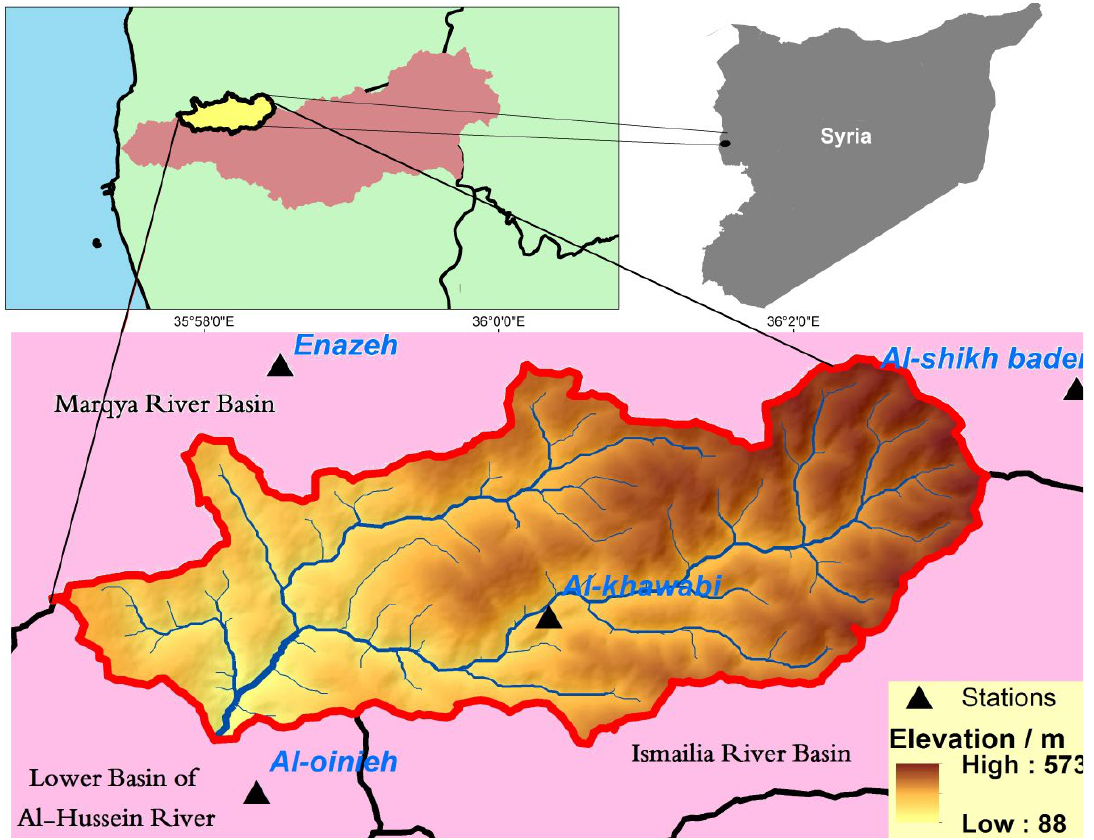
Figure 1. The study area (Khawabi river